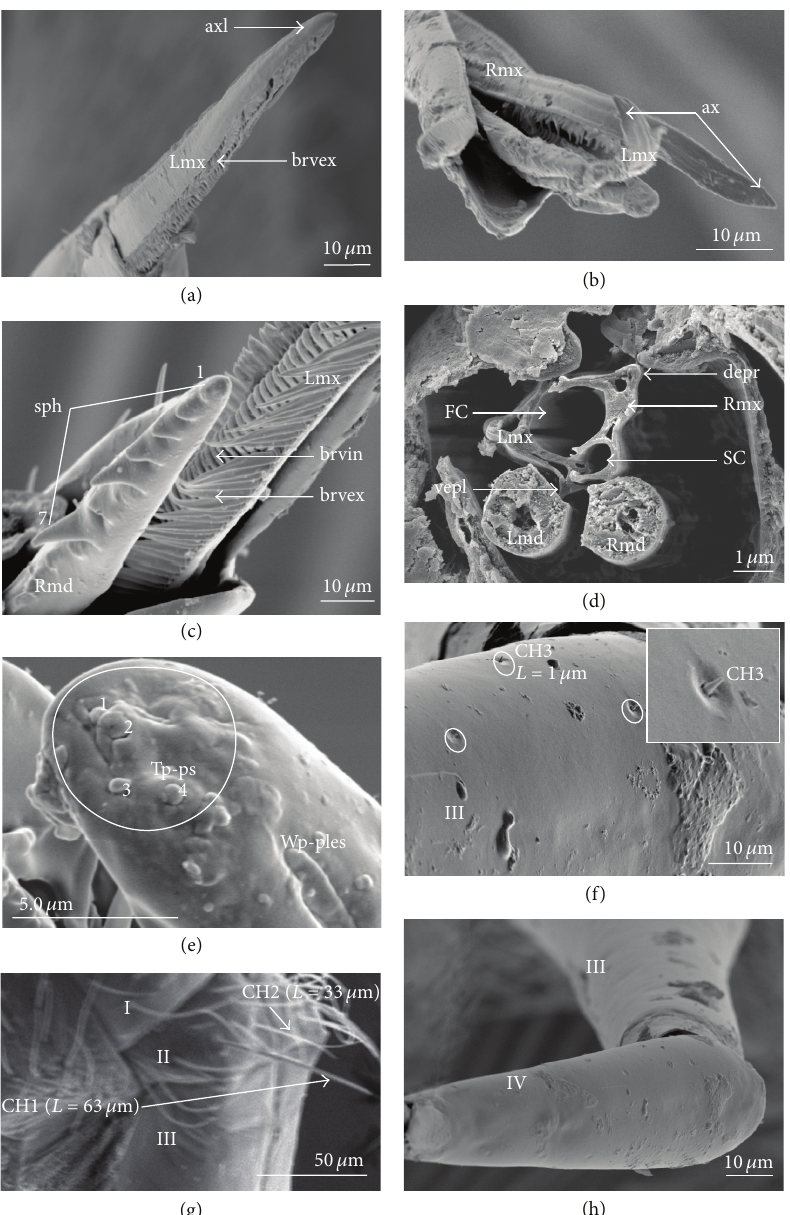
Figure 1: A set of characters for the maxillae, mandibles, and labial sensilla of Mesovelia (Gerromorpha). (a) The shape of the apex of maxillae, the left apex (axl) is visible, exposed, the ventral rupturing device (brvex) is visible. (b) The straight and narrow apice (ax) of both maxillae (Rmx, Lmx). (c) Right mandibular file (Rmd) consists of seven short spines (sph); the file is of medium length, two rows of spines in the rupturing device: internal (brvin) and external (brvex). (d) Cross-section of maxillae (Rmx and Lmx) and mandibles (Rmd and Lmd). (e) The labial tip with peg, uniporous sensilla (Tp-ps) and subapically placed elongated, multiporous plate sensillum (Wp-ples). (f) An arrangement of the mechanosensilla, several short chaetica sensilla (CH3) on the third labial segment. (g) Numerous chaetica sensilla, long (CH1) and of medium length (CH2) placed on the first and second segment, dorsally. (h) The sensilla are small and a few are present on the third and fourth segments, FC: food canal; SC: salivary canal; depr: dorsal external process, right; vepl: ventral external process,